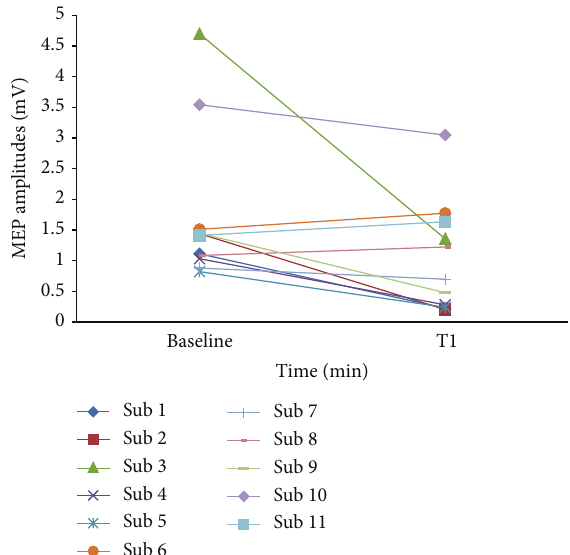
Figure 4: Comparison of the original MEP amplitudes at 1 minute after stimulating with protocol of 1-minute stimulation of 0.25 Hz PAS 10 ms with baseline of all 11 subjects. The greatest inhibitory effect was seen at 1 minute after stimulating with the protocol of 1-minute stimulation of 0.25 Hz PAS 10 ms . Inhibitory effects were found in 8 subjects whereas other 3 subjects showed mild elevation. Sub = subject, MEP = motor-evoked potential, and PAS 10 ms = paired associative stimulation with interstimulus interval of